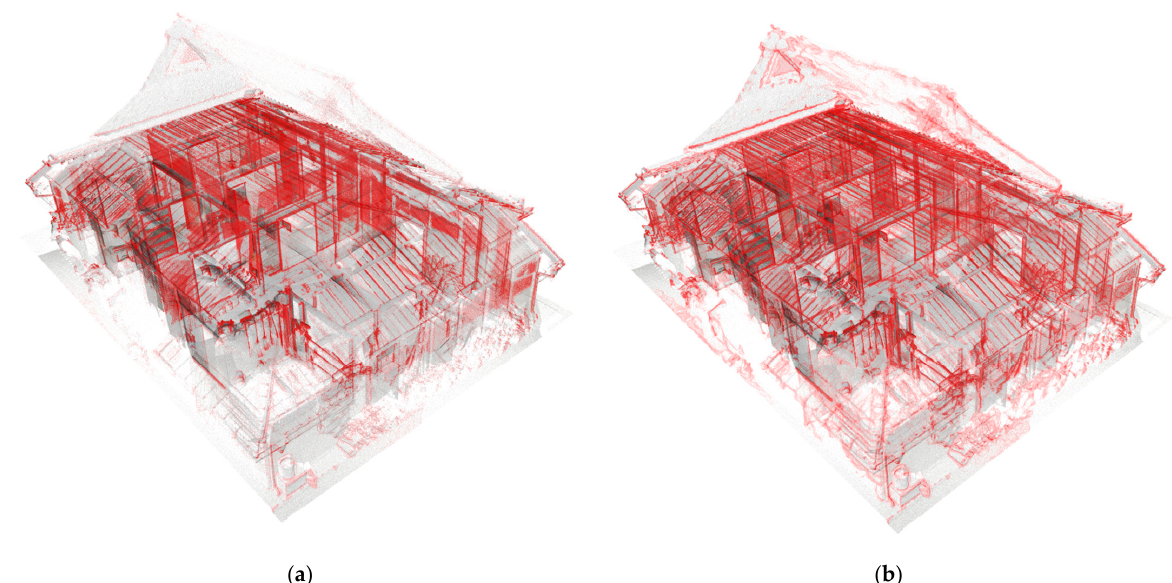
Figure 6. Edge highlighting transparent visualizations of the 3D-scanned data in Figure 4. ( a ) is created based on the integrated point dataset composed of the original 3D-scanned points and the extracted edge points in Figure 5a. ( b ) shows a similar visualization in which the upsampled edge points in Figure 5b are used instead.